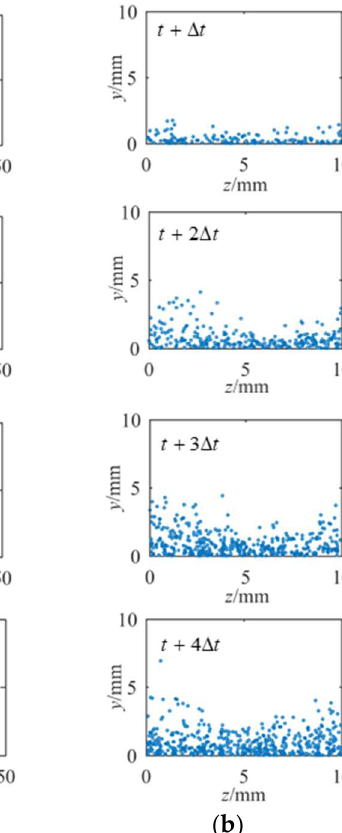
Figure 11. Projection of microbubble distribution on an x–y plane ( a ) and a z–y plane ( b ) at four different moments.